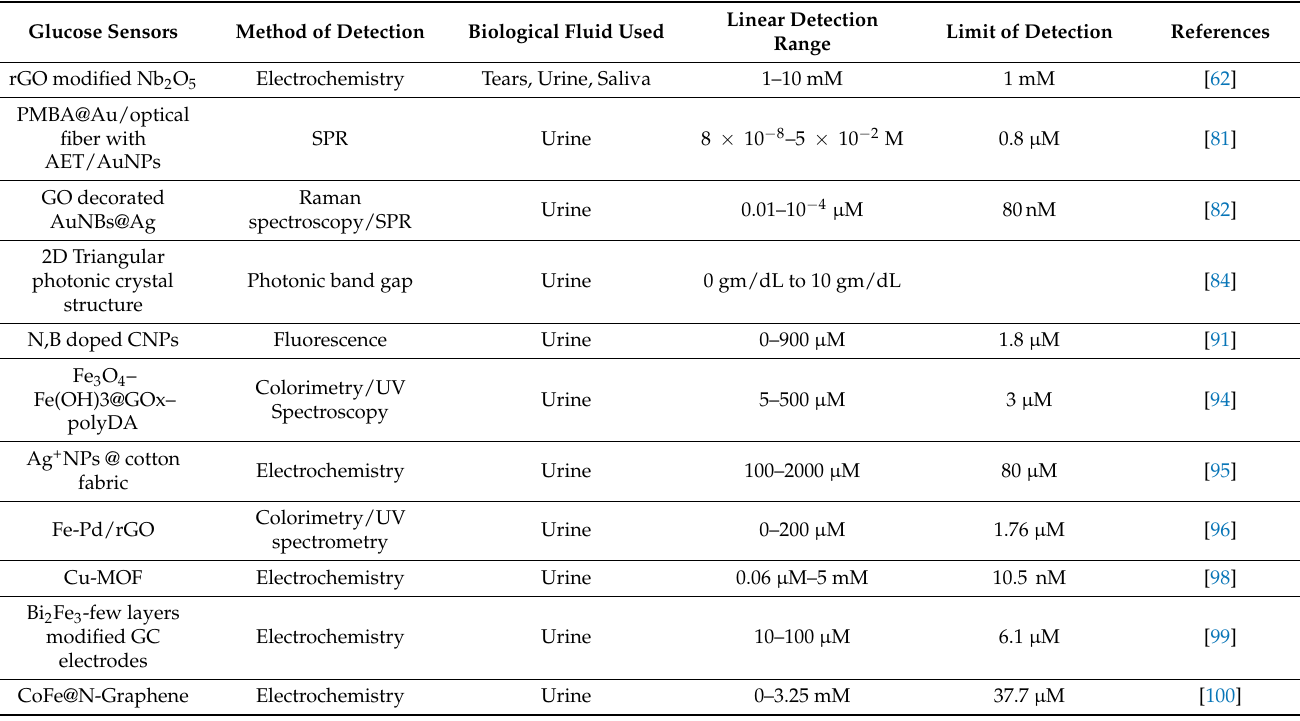
Table 3. The performance of various urine-based glucose